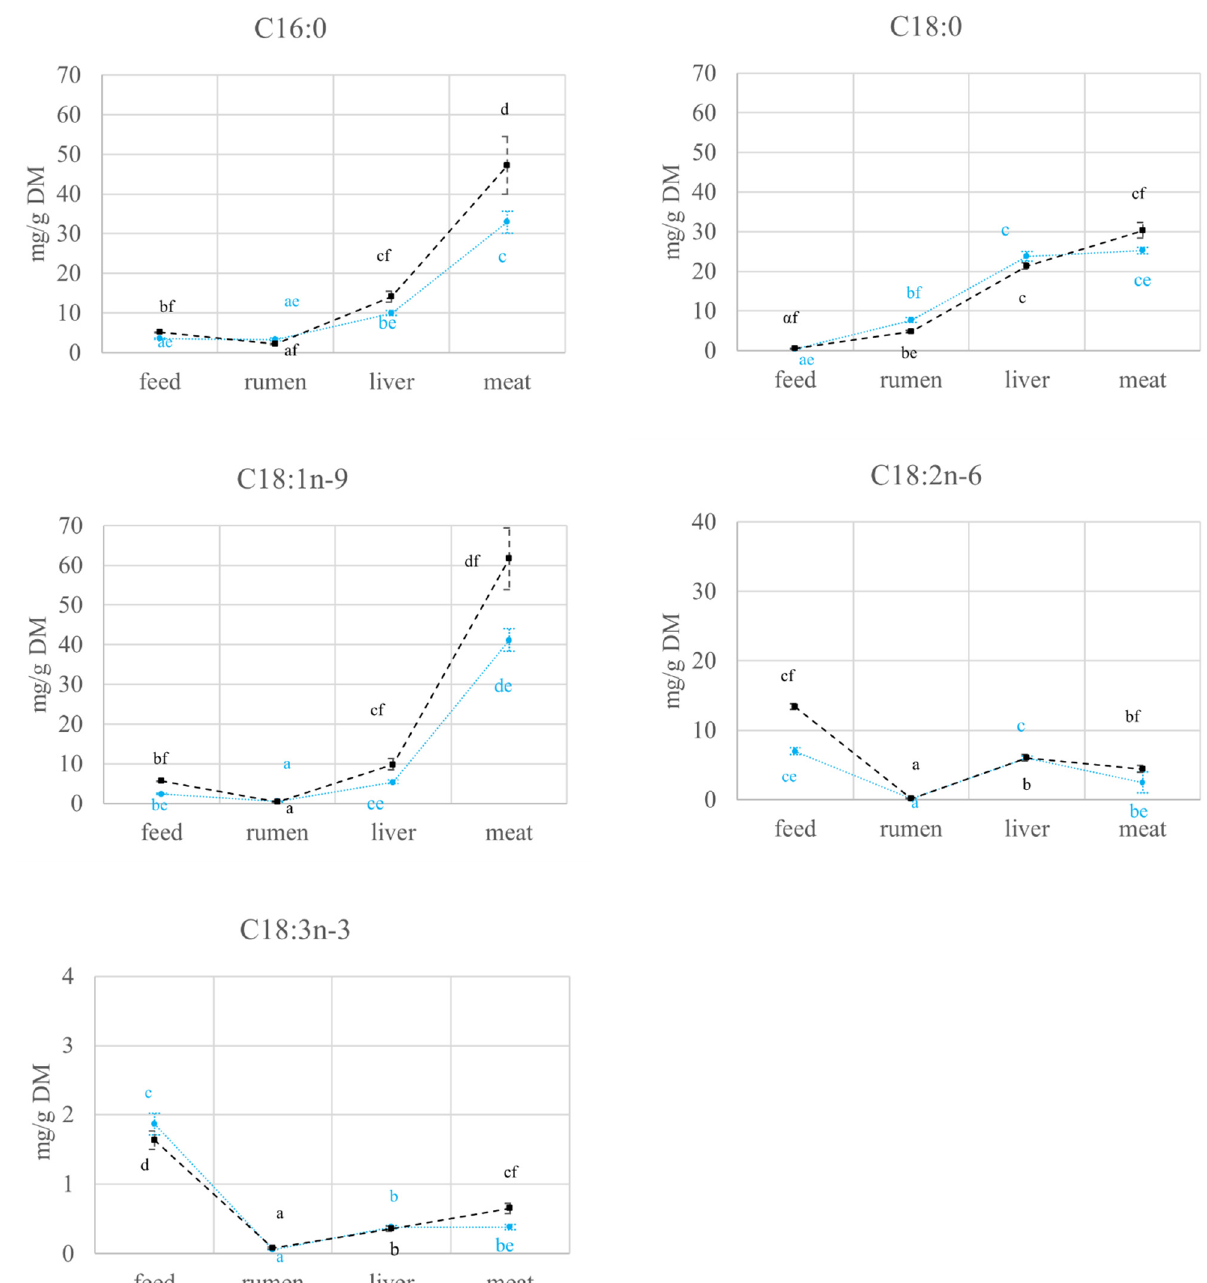
(Figure 2). As for C18:3n-3, its percentage was statistically higher in the C4 group than in the C3 one in the rumen compartment and numerically higher in the meat compartment (Figure 2). These results agree with those of Boerman et al. [23], who reported that the FAs amount available for absorption in the intestine was similar to that leaving the rumen.